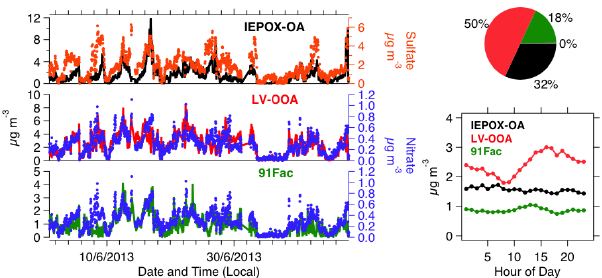
Figure 3. Left panel shows the PMF 3-factor solution time series mass contributions measured by ACSM. Top to bottom: left ordi- nate, IEPOX-OA (black), LV-OOA (red), and 91 Fac (green); right ordinate, sulfate (orange) and nitrate (blue). Right panel shows av- erage mass contributions (top) and diurnal variation (bottom) of fac- tors resolved by